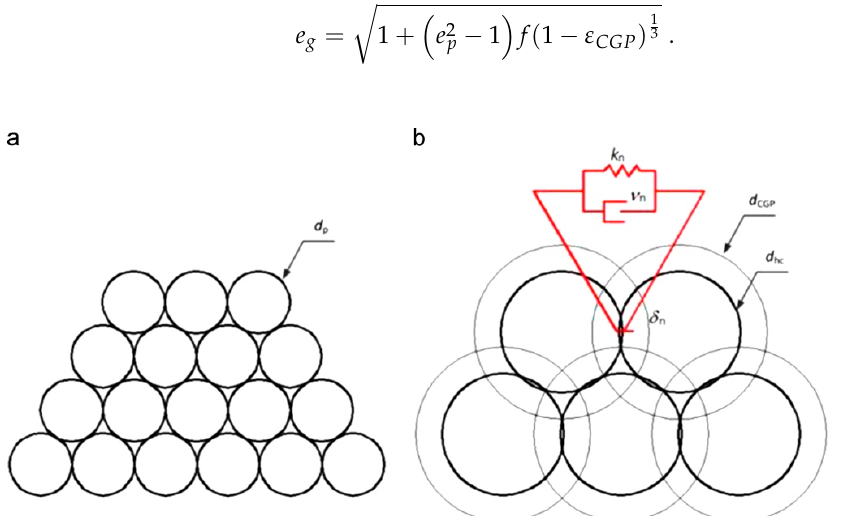
Figure 6. Contact model between grains in the EMMS-DPM approach: ( a ) actual particles; ( b ) rep- resentative grains in contact and linear spring-dashpot model. Note that 𝑑 (cid:3004)(cid:3008)(cid:3017) = 𝑑 (cid:3034) in the present resentative grains in contact and linear spring-dashpot model. Note that d CGP = d g in the present notation. Reprinted from [16], with permission from Elsevier. notation. Reprinted from [16], with permission from